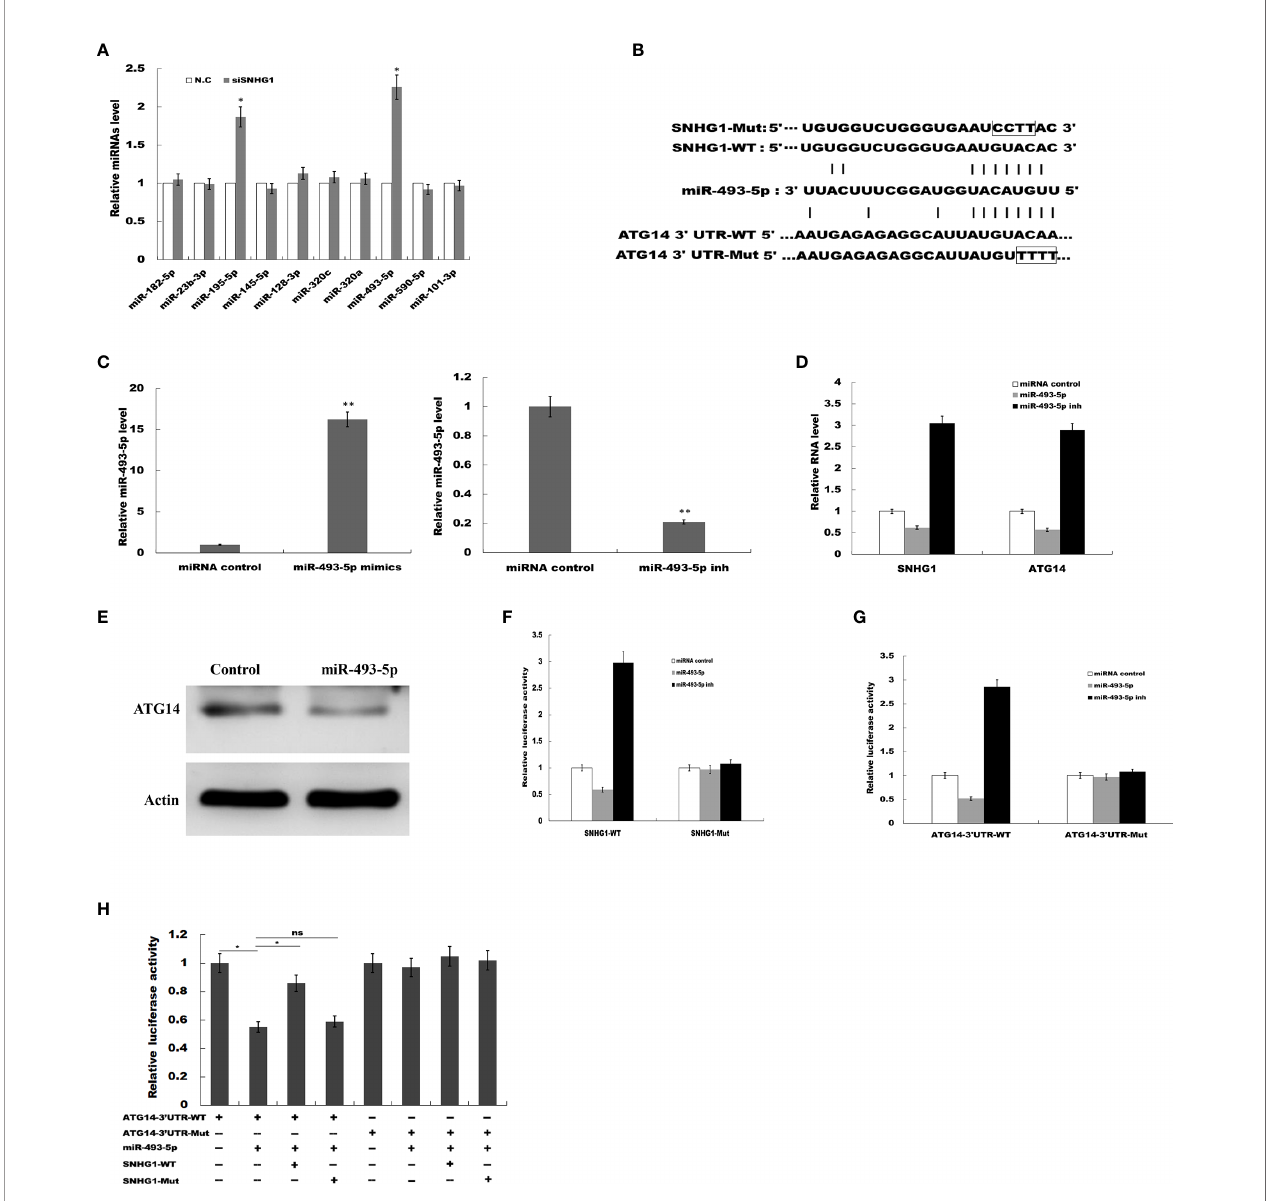
FIGURE 4 | Mechanisms dissecting the role of SNHG1 associated networks in bladder cancer autophagy. (A) T24 cells were cultured with sh- SNHG1 and control, and qPCR was used to determine the expression levels of miR-182-5P, miR-23b-3P, miR-195-5P, miR-145-5P, miR-128-3P, miR-320c, miR-320a, miR-493-5P, miR-590-5P and miR-101-3P. (B) Binding site of SNHG1 wild type, SNHG1 mutation, miR-493-5P, ATG14 3 ’ UTR wild type, and mutation. (C) qPCR was used to determine the ef fi ciency of miR-493-5P mimics and inhibitors in T24 cells. (D) Treatment of T24 cells with miR-493-5P mimics or miR-493-5P inhibitor, qPCR was used to determine the relative expression level of SNHG1 and ATG14 . (E) Treatment of T24 cells with miR-493-5P mimics or control, western blot was used to determine the protein level of ATG14 . (F) Luciferase assay was used to determine luciferase activity after co-transfection of SNHG1 constructs of the wild type or mutant seed regions into T24 cells. (G) Luciferase assay was used to determine luciferase activity after co-transfection of ATG 14 3 ’ UTR constructs of the wild type or mutant seed regions into T24 cells. (H) Luciferase assay was used to determine luciferase activity after co-transfection of SNHG1 constructs of the wild type or mutant and ATG 14 3 ’ UTR constructs of wild type or mutant seed regions into T24 cells (Data presented as mean ± SD, NS, no signi fi cance, *p < 0.05, **p < 0.01 compared to the